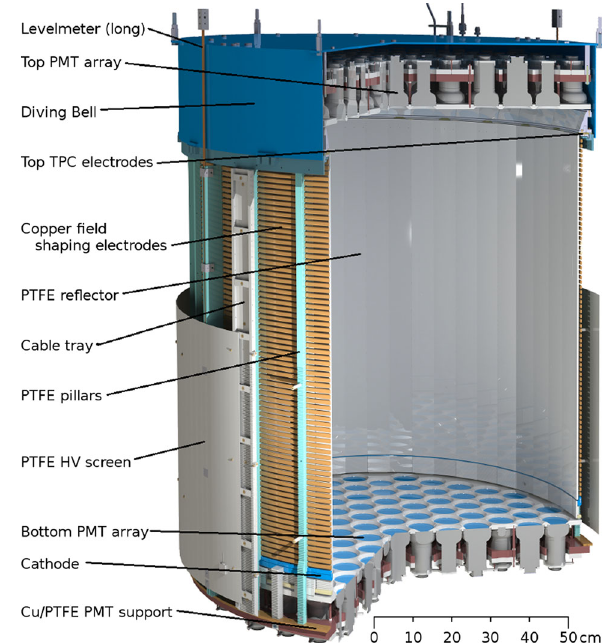
Fig. 2 Illustration of the XENON1T TPC. It is built from materi- als selected for their low radioactivity, e.g., OFHC copper, stainless steel and PTFE. The top and bottom PMT arrays are instrumented with 127 and 121 Hamamatsu R11410-21 PMTs,